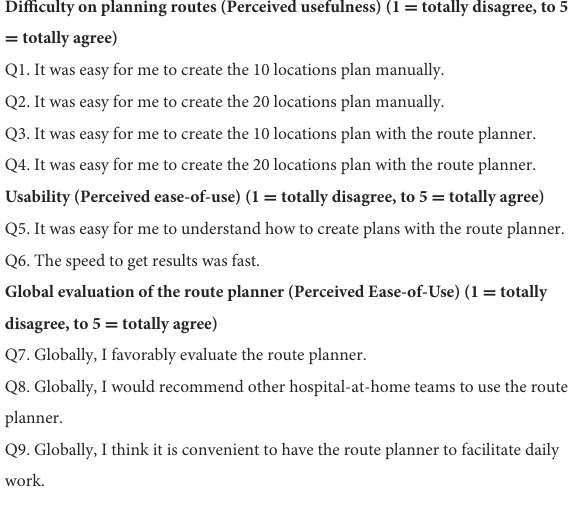
TABLE 2 Phase 3: questionnaire to evaluate the usability and convenience of the route planner. Difficulty on planning routes (Perceivedusefulness) (1 = totally disagree, to 5